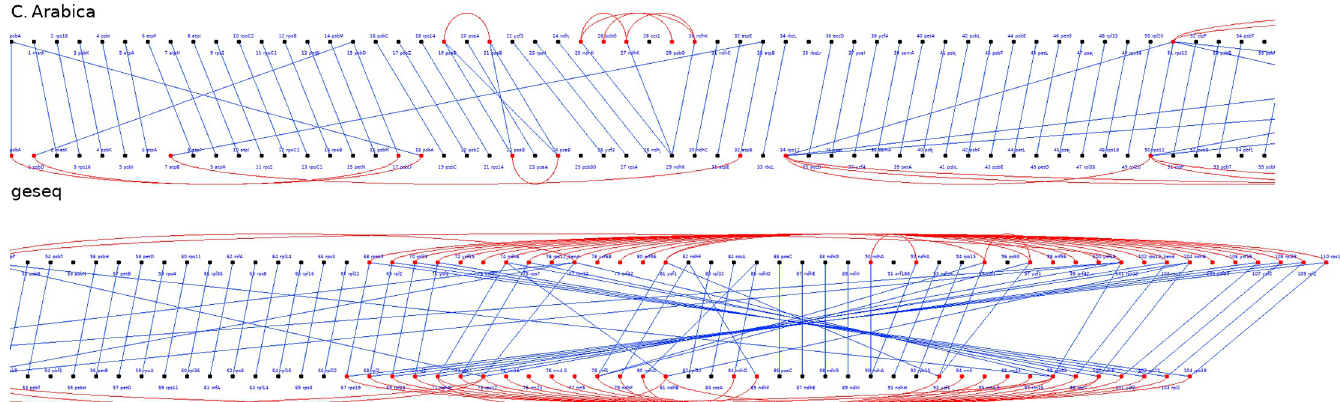
Fig 1. Annotation differences from Dogma and GeSeq using C . arabica Cp genome as study case. The Cp genome, split into two parts, is described as an ordered list of predicted coding sequences, leading to two black dotted lines for each part, surrounded by gene names written in blue. In each part, the upper line entitled C . arabica corresponds to the Dogma annotations, while the lower line is for GeSeq. A red edge indicates paralogous genes within a given genome, while a blue line is drawn when predicted sequences are similar between the two annotations.